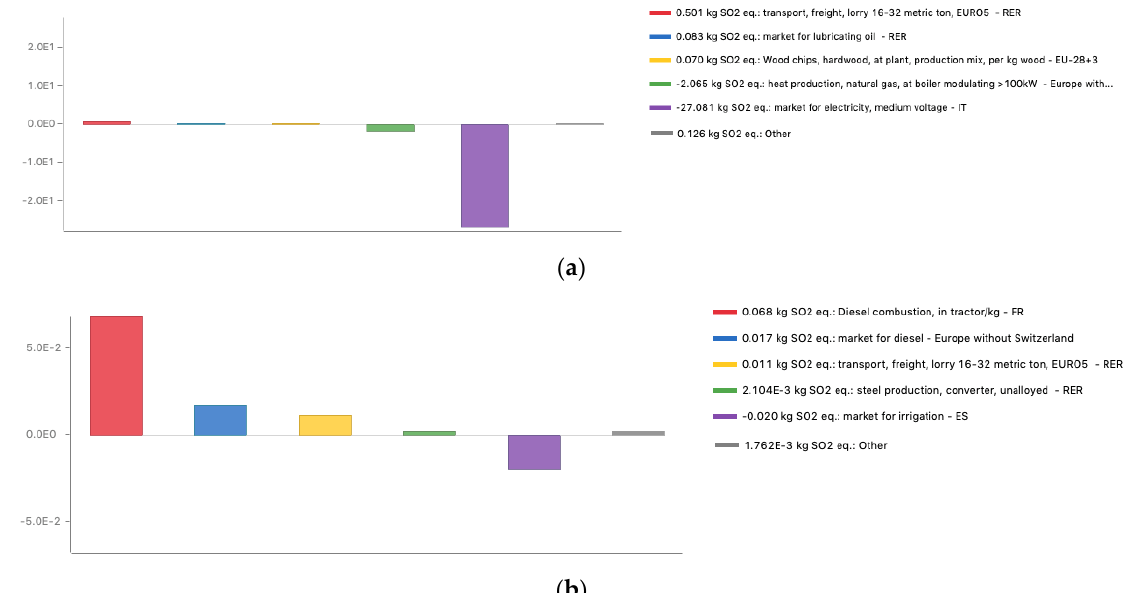
Figure 3. Acidification potential: top 5 contributions impacting category results: ( a ) Cradle-to-grave analysis; ( b ) Downstream process.